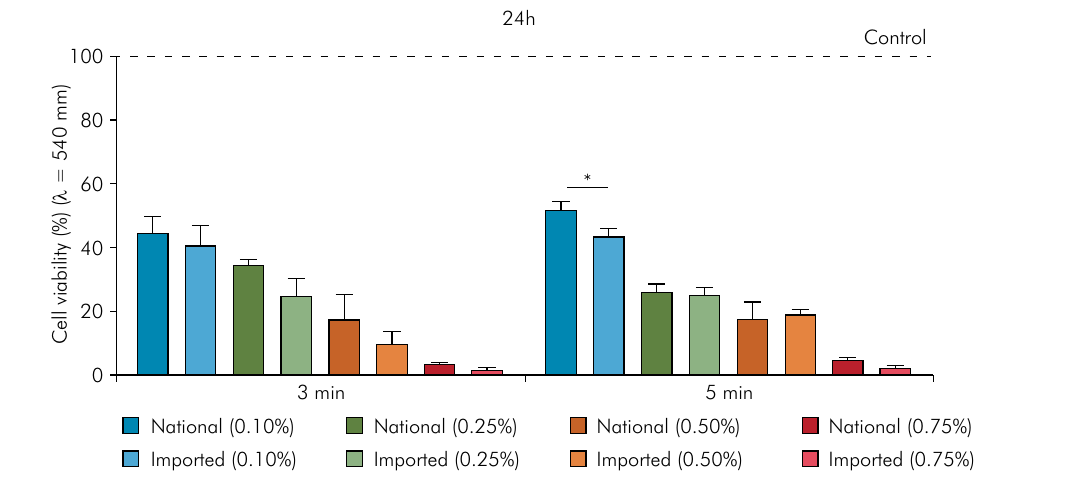
Figure 2. MTT assay 24 h (T1) after exposure of cell cultures to the different CSs diluted to concentrations ranging from 0.10% to 0.75%; comparison of epithelial cells exposed to both NCS and ICS for 3 or 5 min. # indicates statistical difference between the control and test groups.